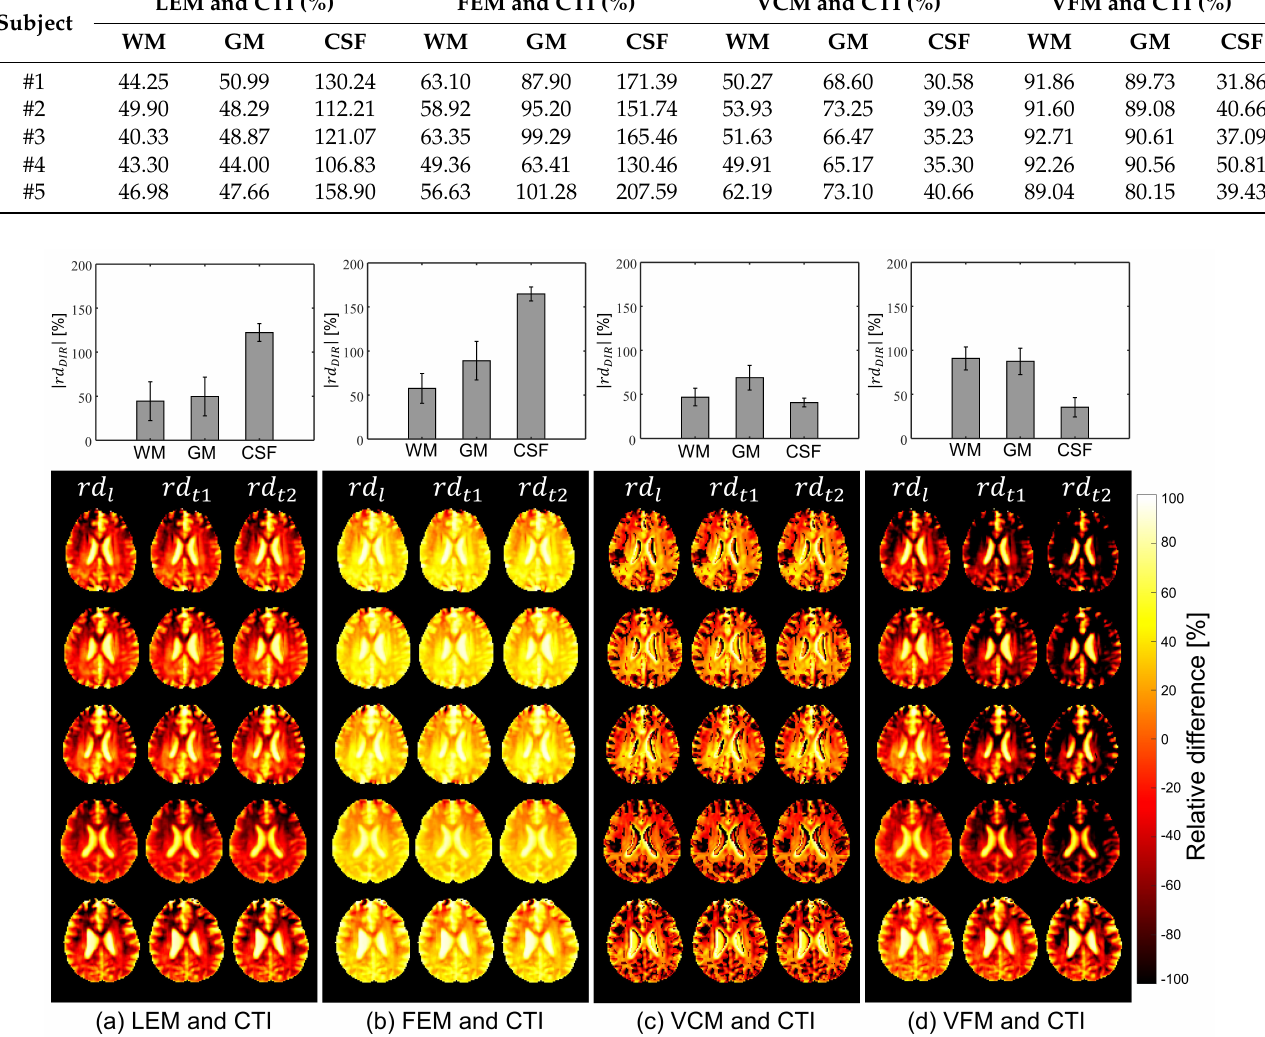
Figure 6. Images of the relative differences in the longitudinal ( e l ) and transversal ( e t 1 and e t 2 ) components between one of the LEM, FEM, VCM, and VFM methods and the CTI method. The graphs at the top are the absolute mean and SD values | ) in the WM, GM, and CSF regions. The bar represents the of the relative differences ( | rd DIR